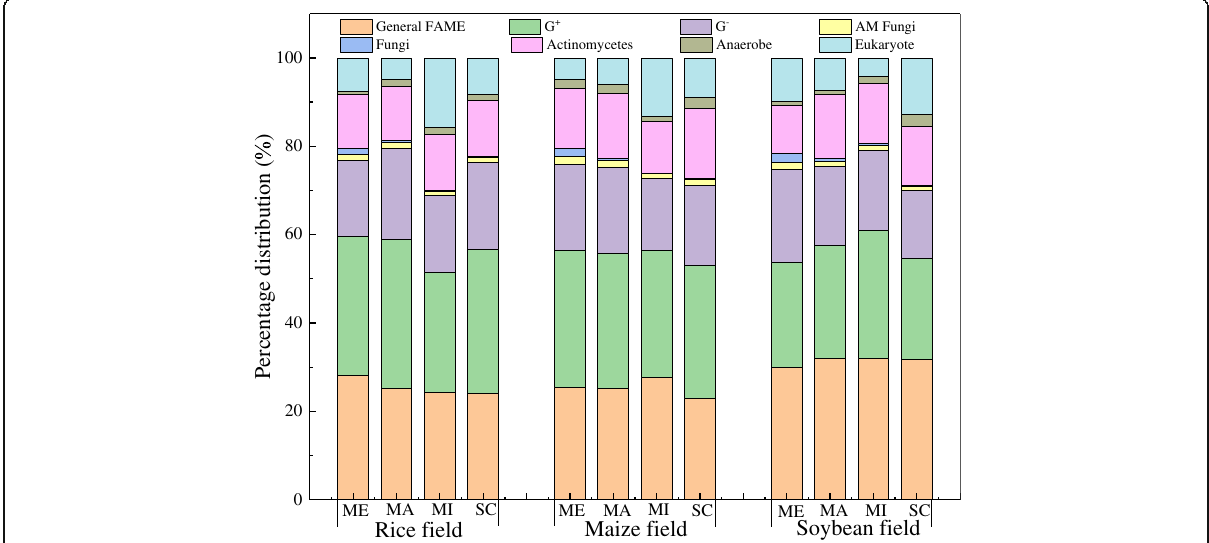
Fig. 2 Changes in microbial communities associated with soil aggregate structure under different croplands